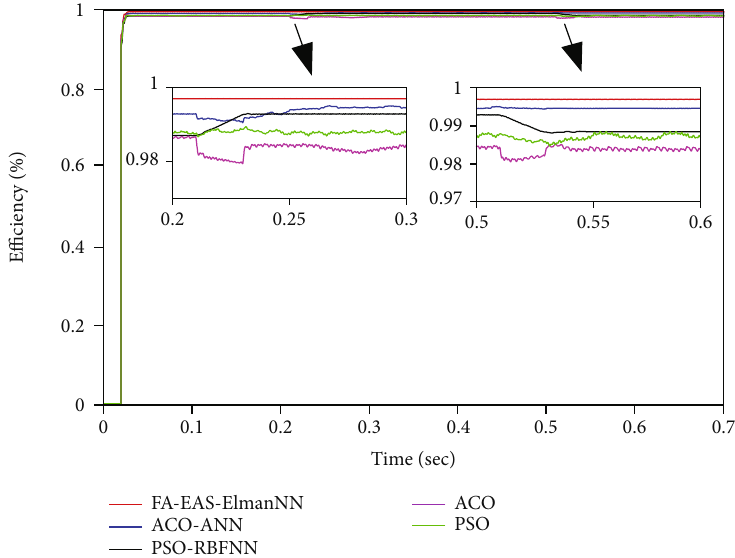
Figure 19: E ffi ciency under rapidly changing G and T .